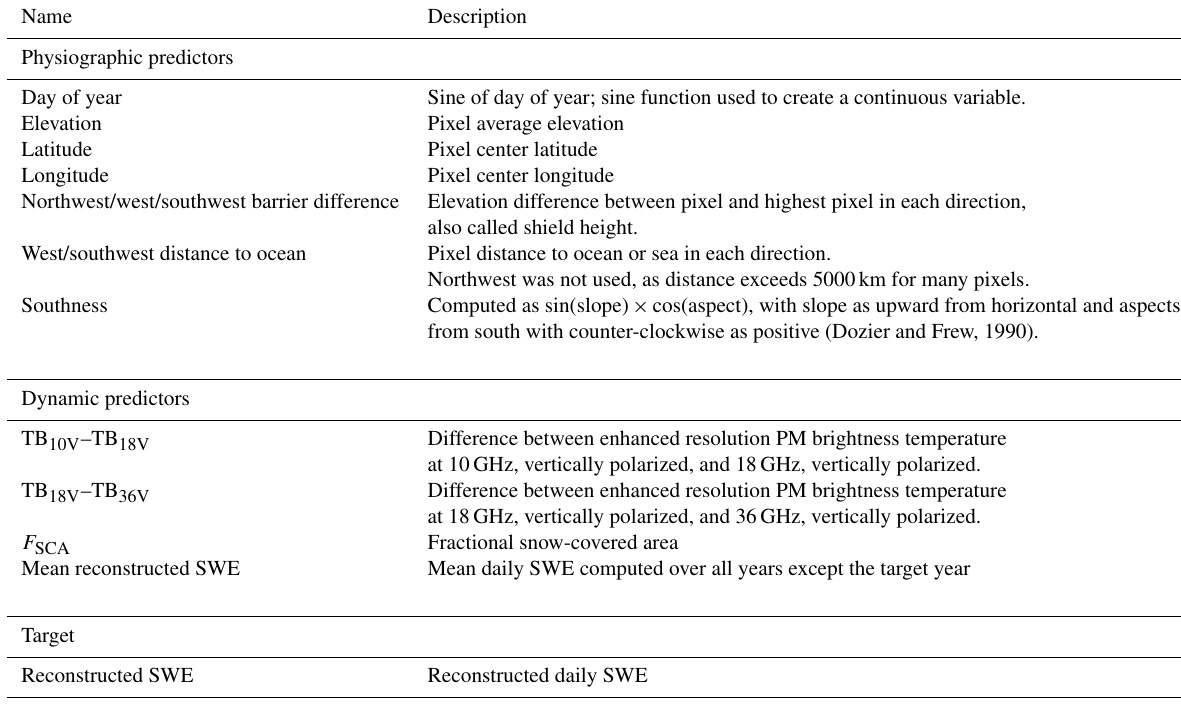
Table 2. Predictor and target